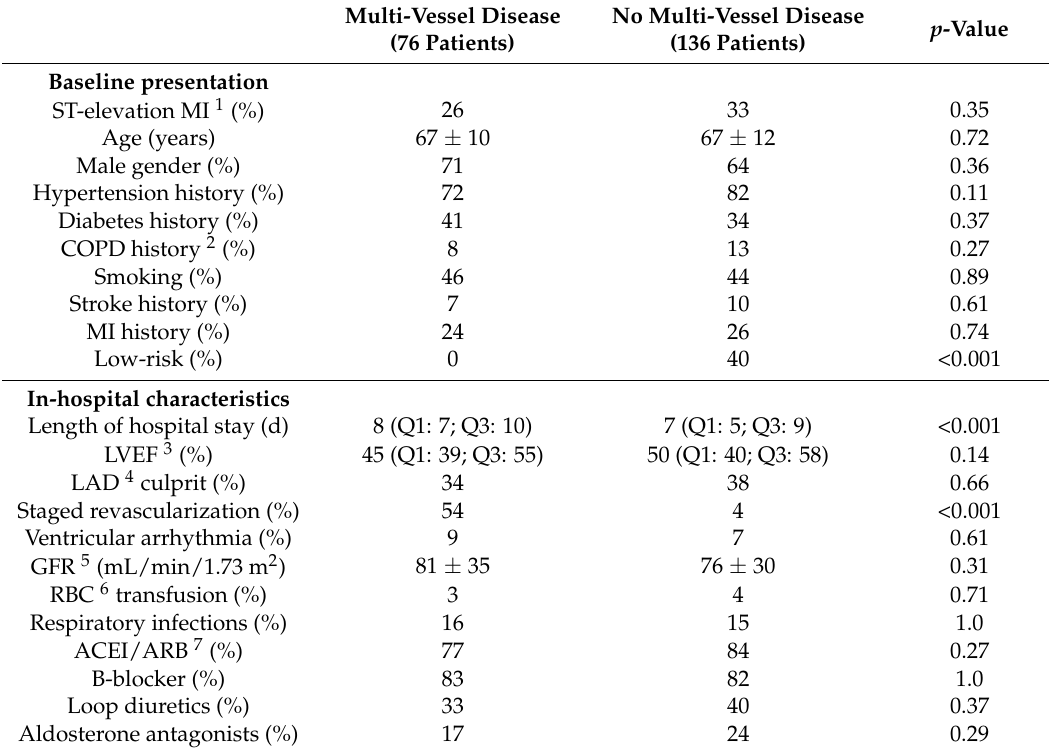
Table 3. Baseline and in-hospital clinical characteristics in relation to the presence of multi-vessel